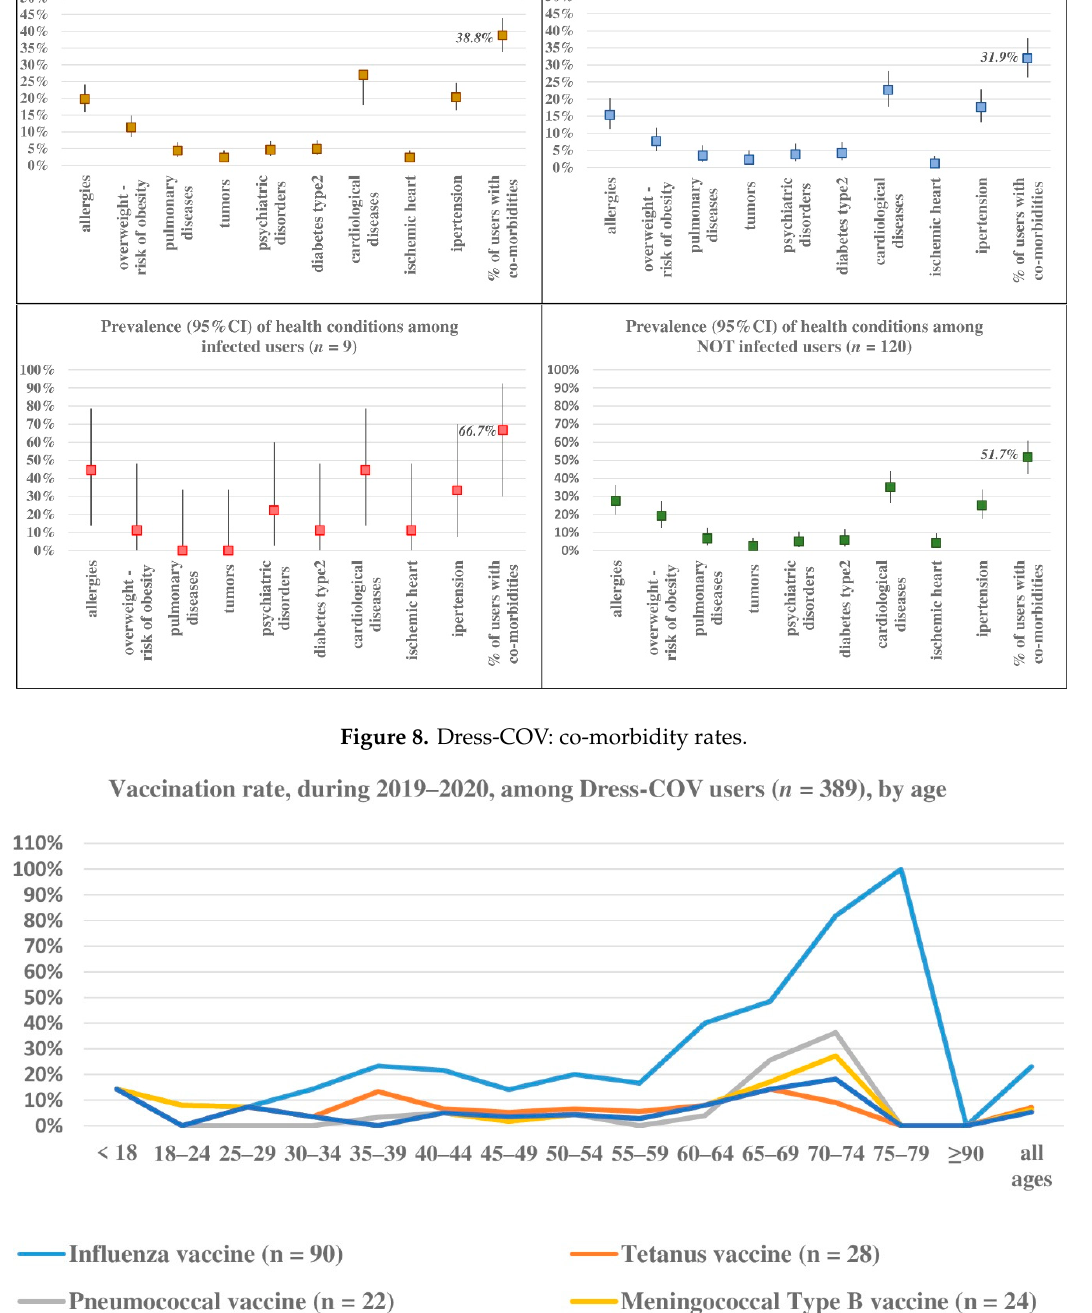
Figure 10. Dress-COV: vaccination rate (2019–2020) by propensity to tests and their results. Co-morbidity rate significantly differs among vaccinated and not vaccinated users (Table 1), although the most relevant difference concerns users who did not undergo virological or serological tests. The vaccination rate amounted to 55.6% (95% CI: 21.2–86.3%) among infected subjects ( n = 5) and, as shown in Table 1, this rate is not very different from that among tested negative subjects (52.5%; 95% CI: 43.2–61.7%). Infected subjects were also characterized by a more notable morbidity rate (80%; 95% CI: 28.4–99.5%). The limited number of infected subjects does not allow for evaluation of the relationship between vaccination and SARS-CoV-2 infection. These results could suggest a possible association between chronic conditions and both the vaccination propensity and the contagion risk.